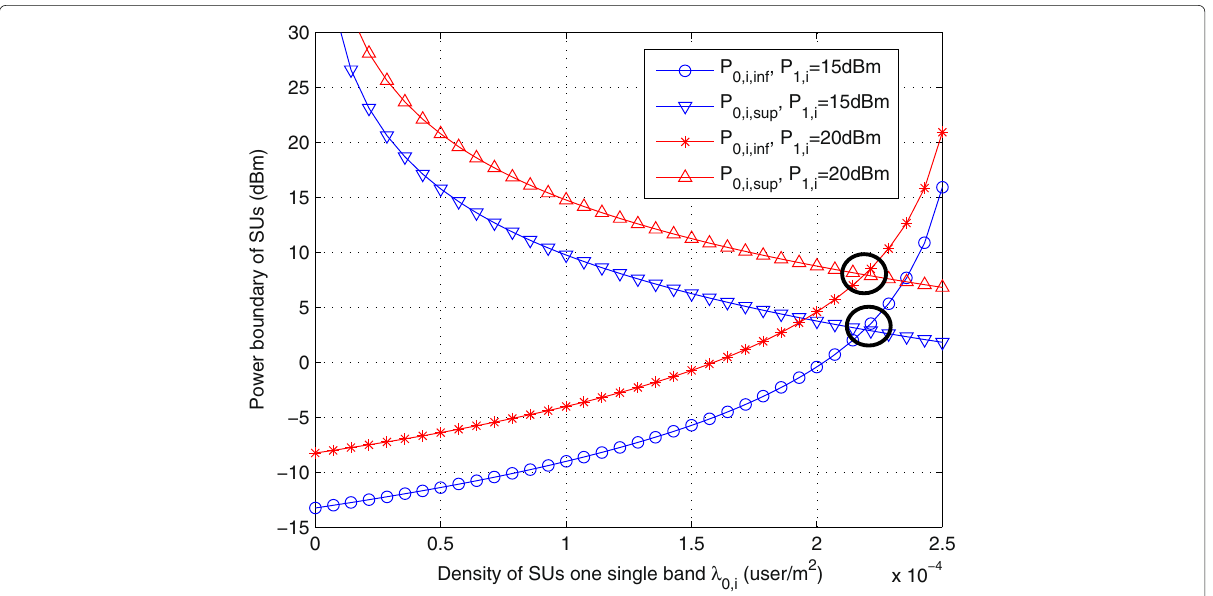
Fig. 5 Power boundary of SUs vs. density of SUs on one single